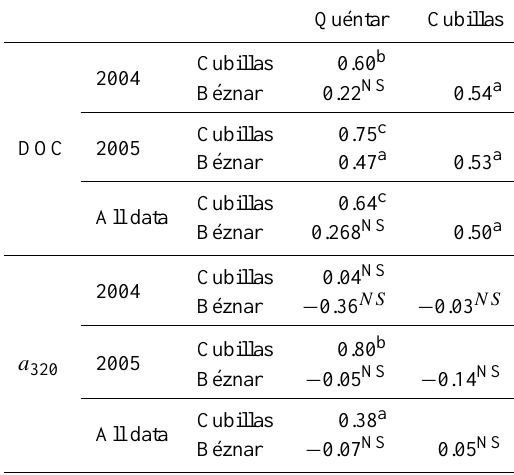
Table 5. Correlation coefficients between the different reservoirs for dissolved organic carbon (DOC) concentrations and absorption coefficients at 320nm ( a 320 ) .